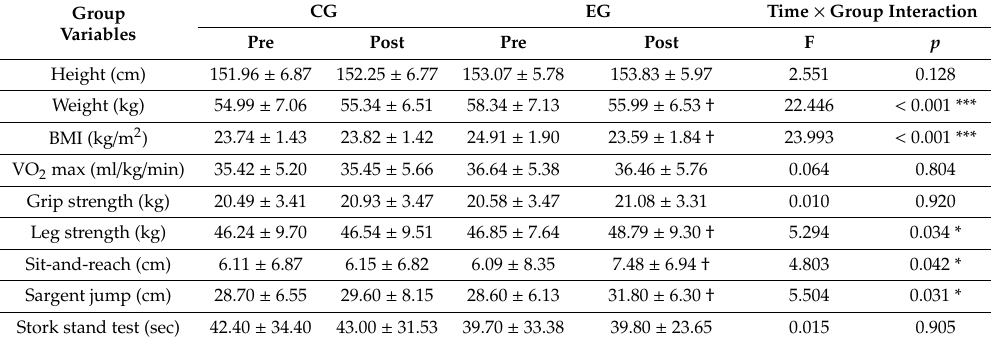
Table 3. Change in physique and fitness over the 16-week intervention.